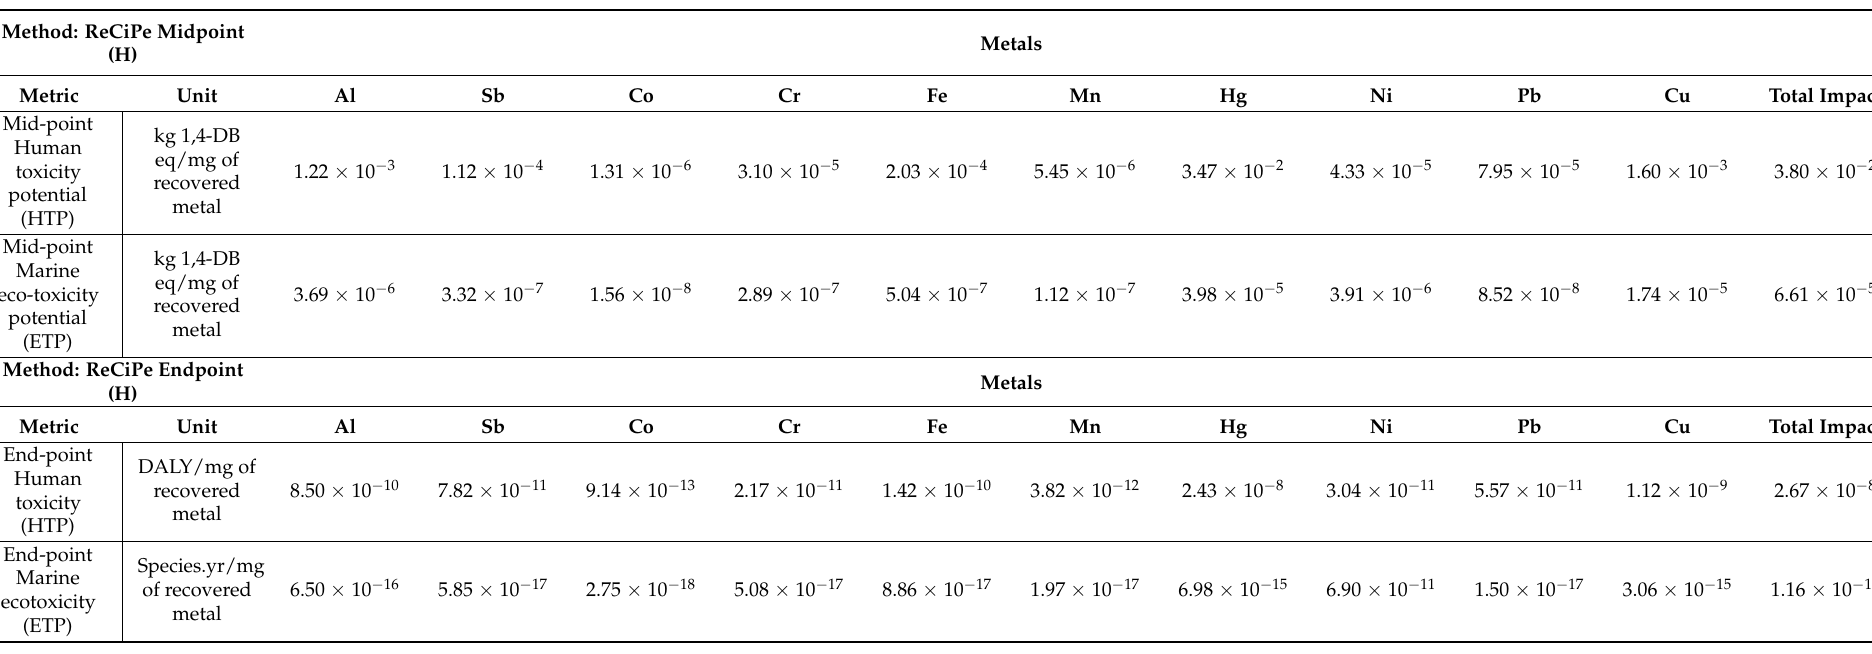
Table 3. Life cycle human toxicity potential (HTP) and marine eco-toxicity potential (ETP) avoided impacts due to recovered metals [mg per m 3 of brine] calculated with ReCiPe mid-point (expressed as kg1,4DB-eq/m 3 brine) and end-point (expressed as DALY/m 3 brine) life cycle impact assessment method, in the case of MDC_2 system. Life cycle toxicity results should be interpreted as a first indication as they may include uncertainties due to different exposures, fates, and effects of toxic chemicals. Recovered metals from brine in the three MDC systems are indicated in Table